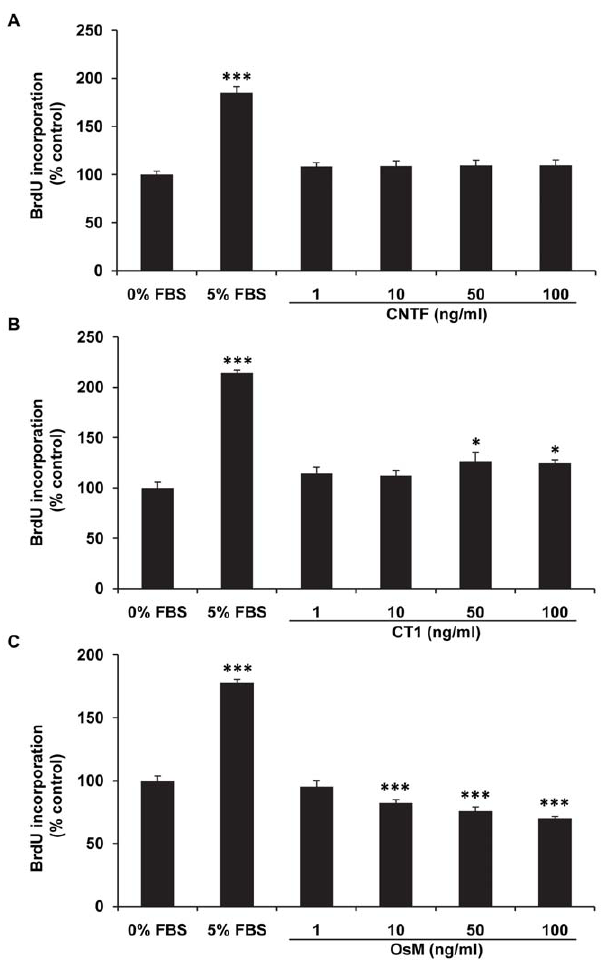
Figure 7. Dose responses of CNTF, CT1, and OsM - induced hfRPE proliferation. CNTF showed no significant effect on hfRPE proliferation, while CT1 significantly increased cell proliferation by 25% (50–100 ng/ml). In contrast, OsM produced a monotonic increase in its inhibitory effect on hfRPE proliferation between 1 and 100 ng/ml. There was a significant difference in inhibition between 1 and 10 ng/ml ( P =0.02) and between 10 and 100 ng/ml ( P =0.001). 5% FBS was used as positive control. (Summary data from two experiments using cells from different donors; * P , 0.05, *** P , 0.001 compared to 0% FBS negative control).